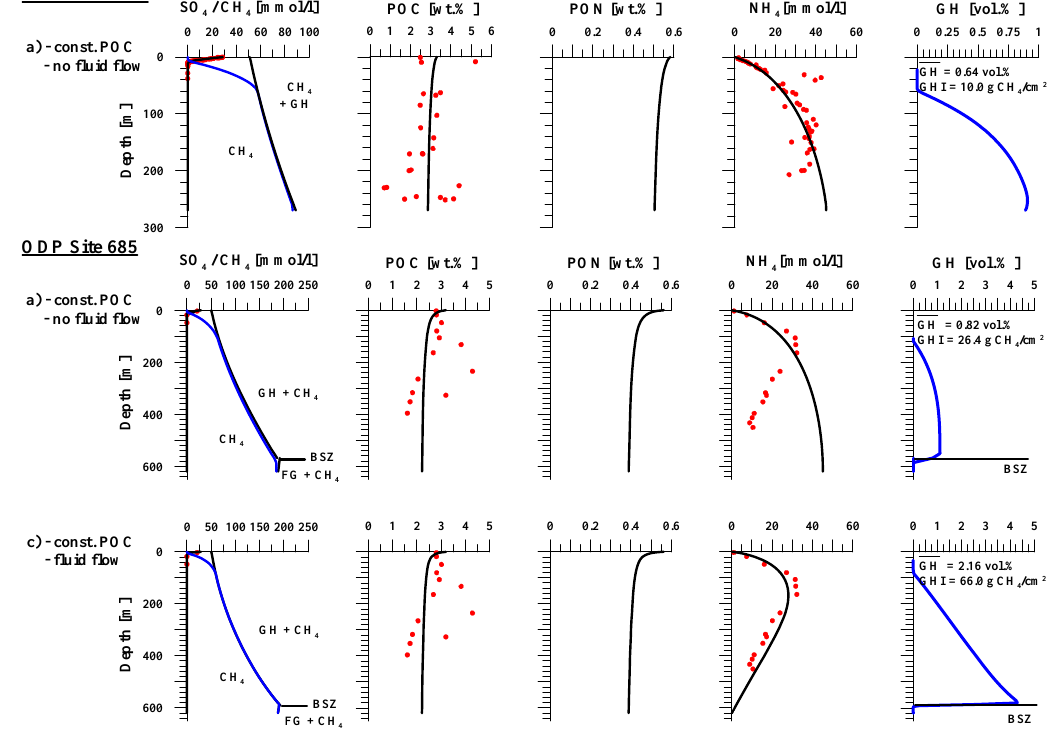
Fig. 3. Model results for ODP Sites 1230 and 685 off Peru for two different model runs: (a) constant POC input, and (c) constant POC input with advective fluid flow.